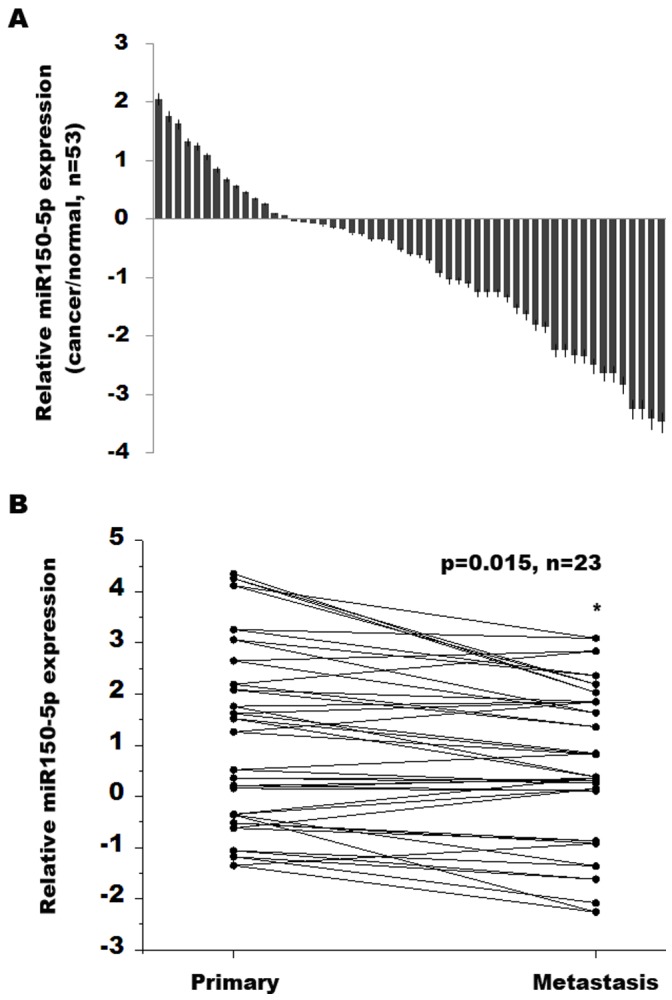
miR-150-5p expression is down-regulated in HCC tissues.(A) Quantitative RT-PCR analysis of miR-150-5p expression level in 53 HCC tissues and pair non-tumor tissues. The results were expressed as Log2 (2–ΔΔCt). (B) Quantitative RT-PCR analysis of miR-150-5p expression level in 23 metastatic and pair primary HCC tissues.